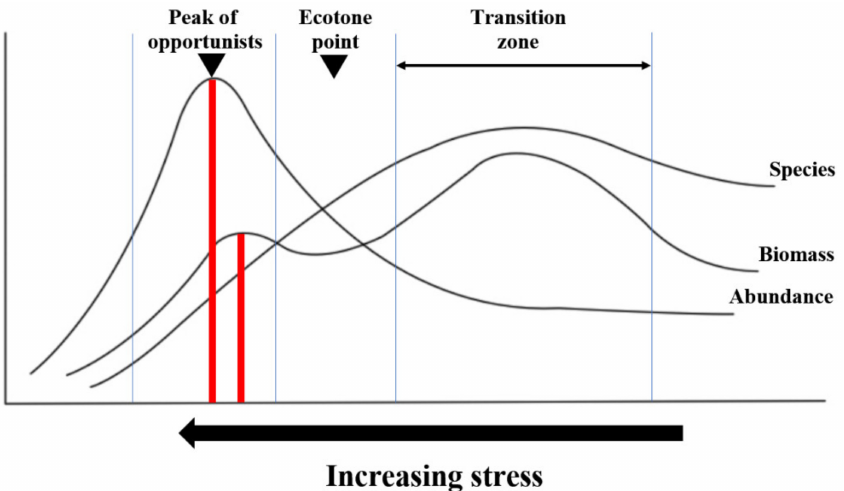
Figure 2. P-R model [6] redrawn for the classification of the five ecological statuses based on the successional characteristics and the normative definitions of WFD Annex V relating to benthic invertebrates. The red bars are benchmarks for measuring the relative magnitudes of SAB to estimate the degree of agreement between the SAB pattern along seven ISEP grades and those in P-R model.